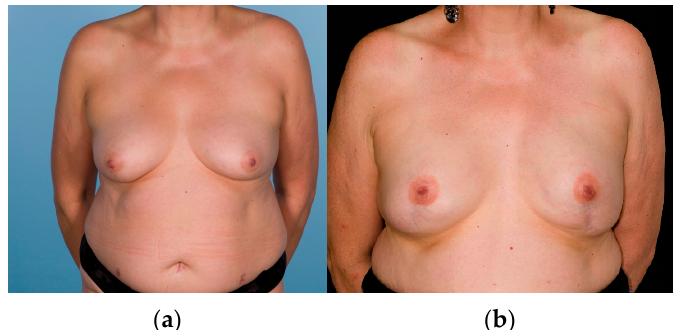
Figure 2. Example of a woman who underwent nipple-sacrificing mastectomy with implant-based reconstruction in the sub-muscular position with lower pole support using acellular dermal matrix. Pre-operative photograph ( a ) and post-operative photograph ( b ).